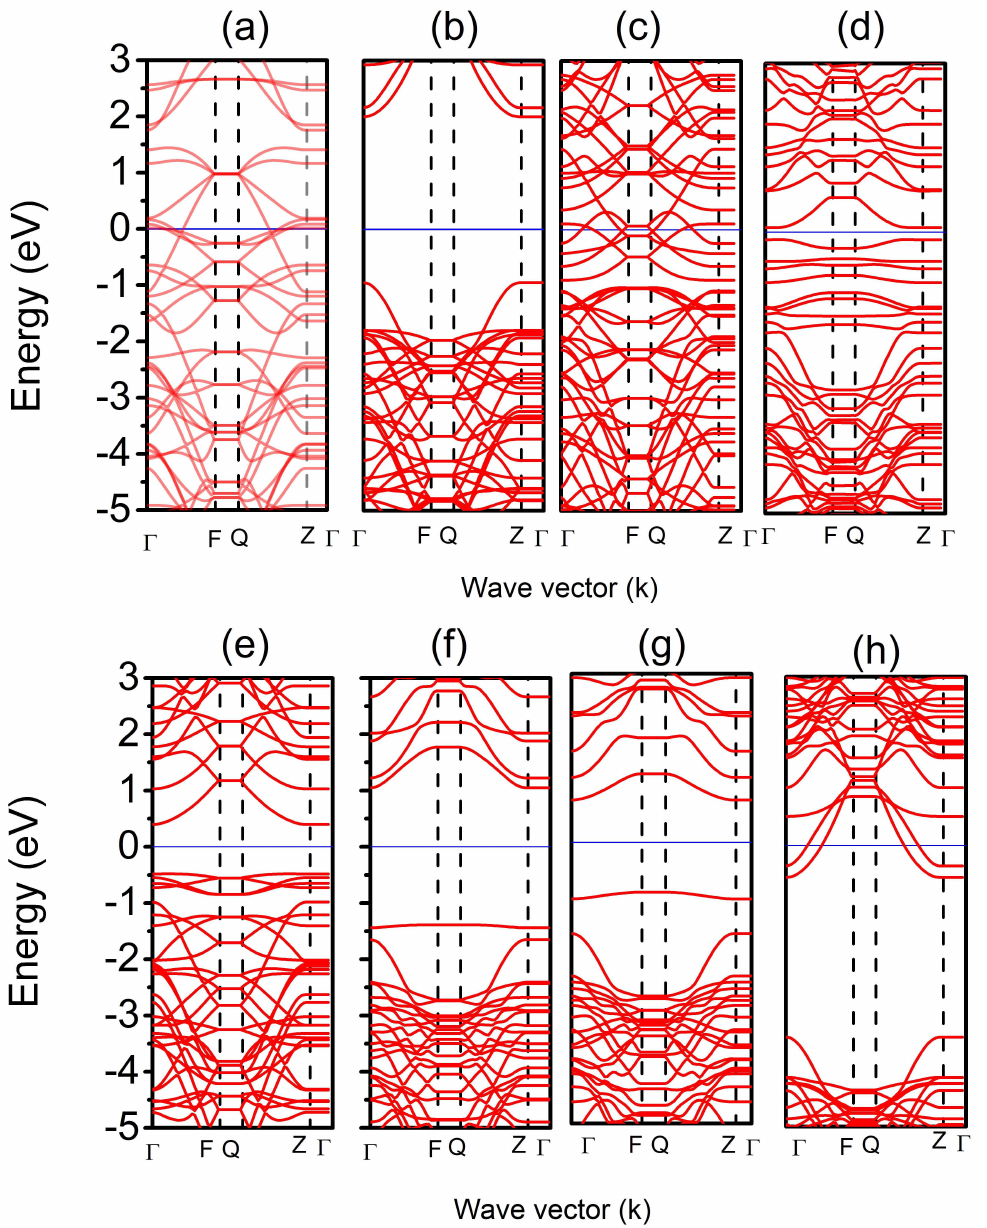
Figure 3. Electronic band structure of symmetric 3C-SiC (1 1 0) surfaces. ( a ) Pristine, ( b ) Full-H, ( c ) Full-Li, ( d ) CH+SiLi, ( e ) CLi+SiH, ( f ) H+1LiC, ( g ) H+1LiSi, ( h ) H+Li c